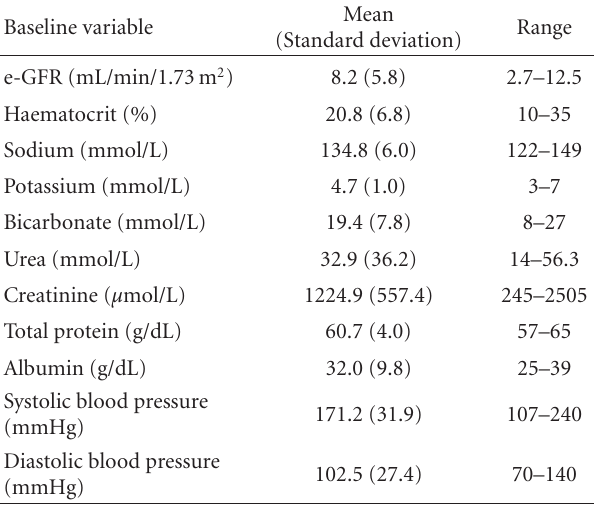
Table 3: Baseline characteristics of study subjects at first presenta-